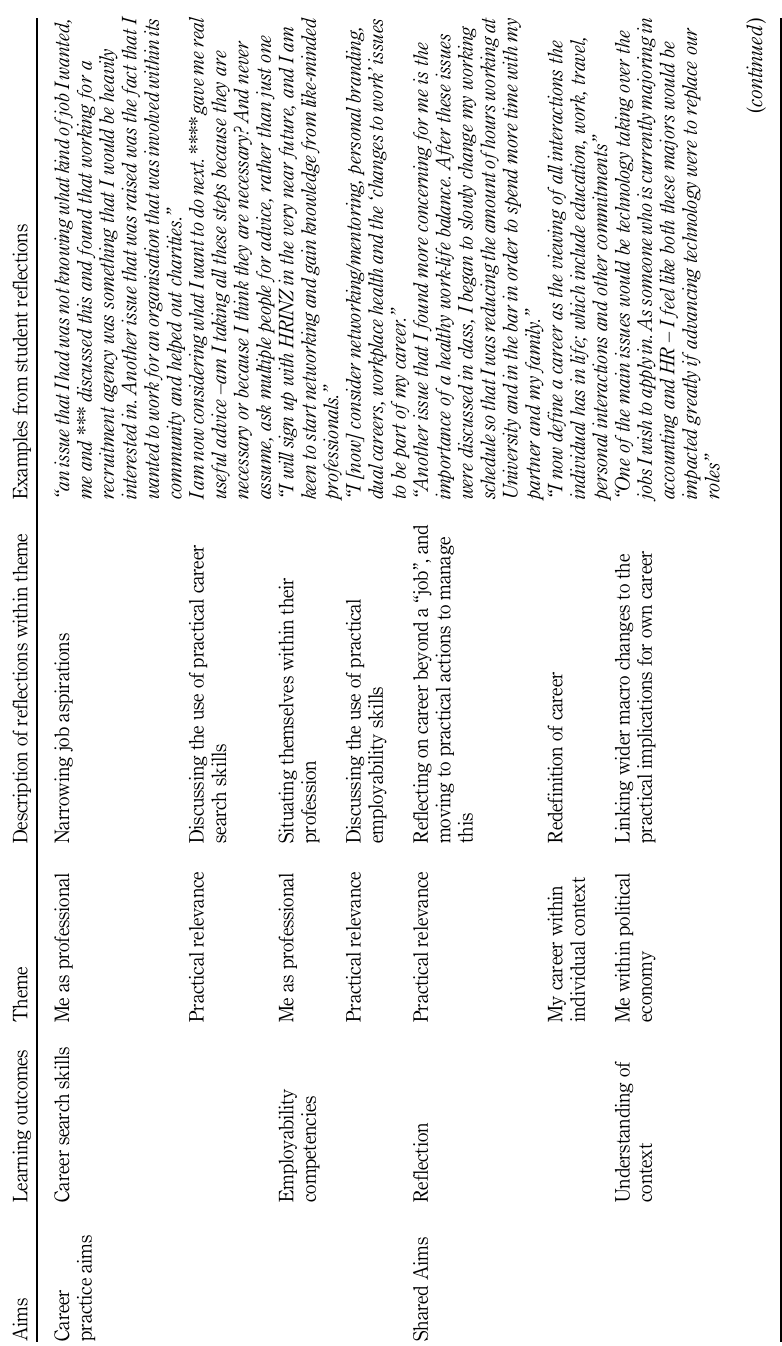
Table 3. Analytical